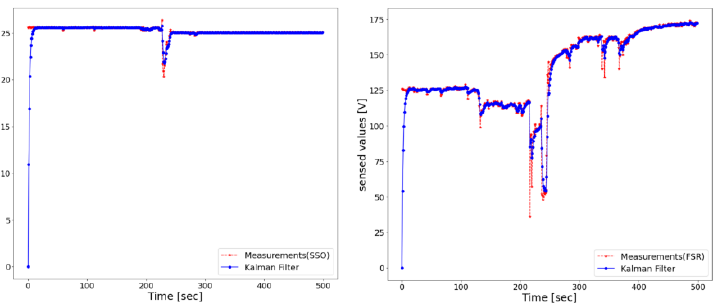
Figure 5. Results of applying a Kalman filter to the ultrasonic sensor ( left ) and the FSR sensor ( right ).